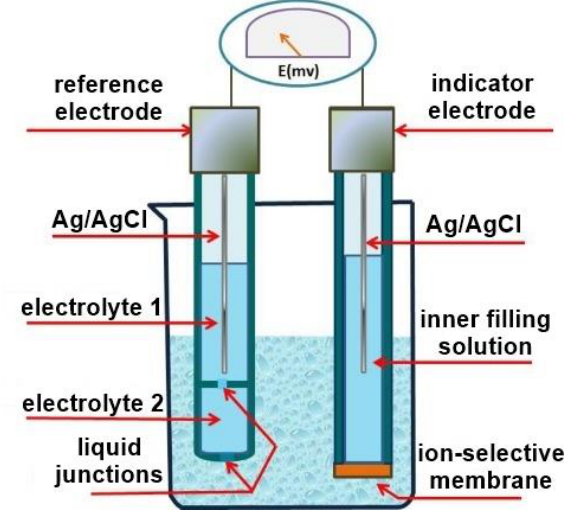
Figure 11. Illustration [43] of the potentiometric cell used for the present electrochemical studies.